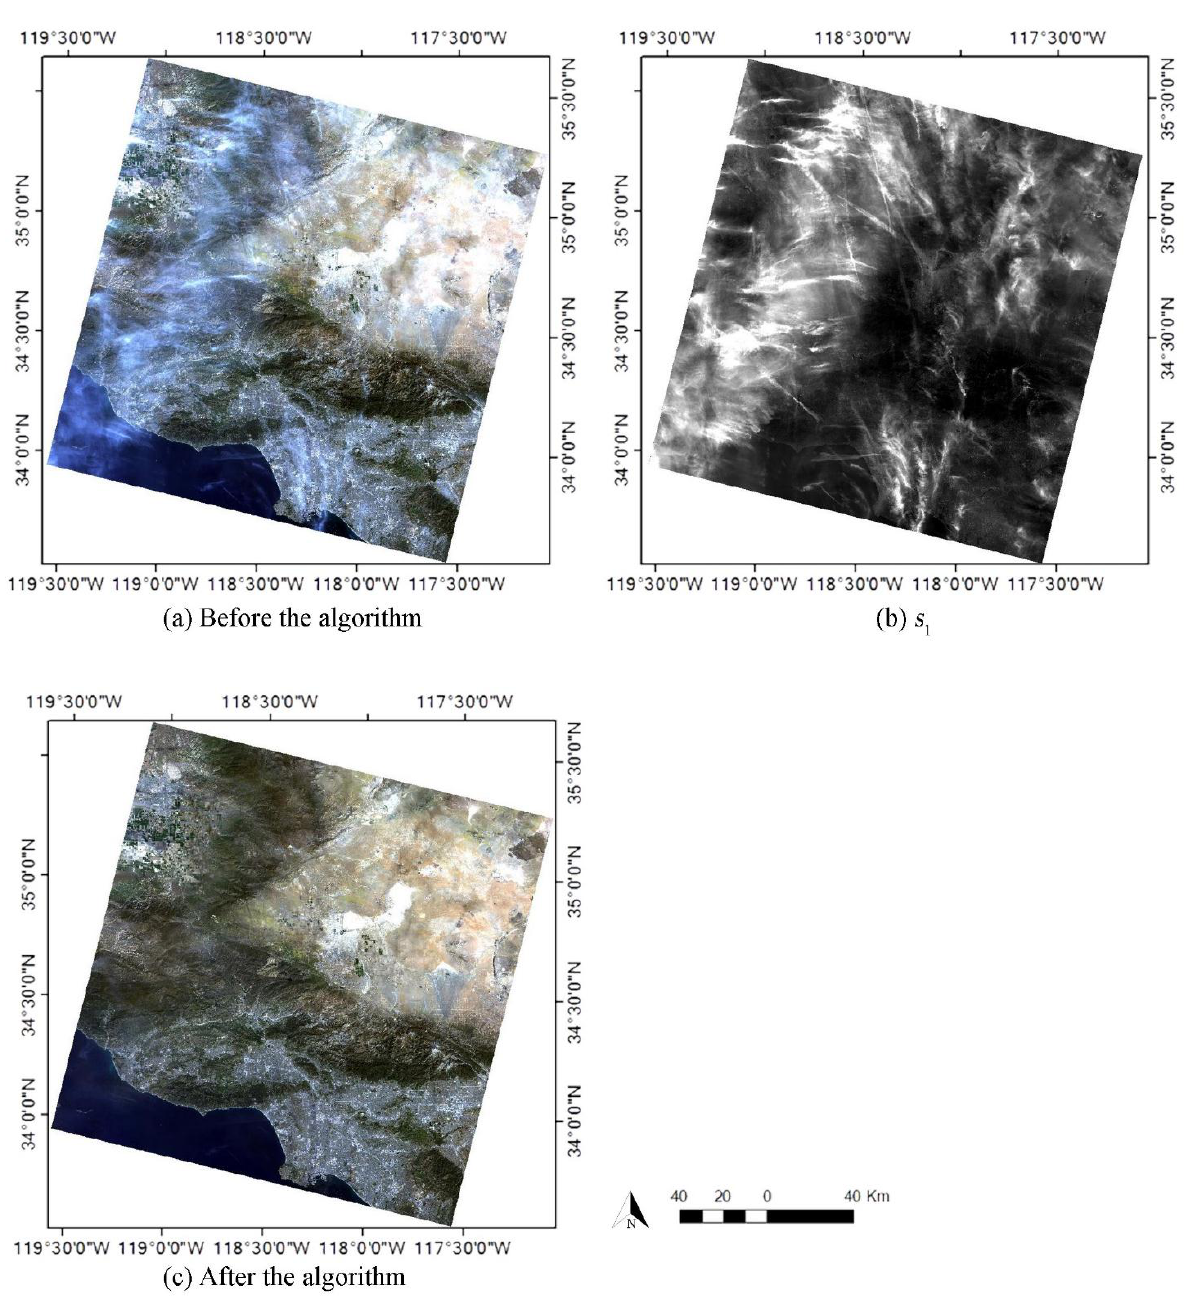
Figure 12. ( a ) The Landsat image of p41/r36 was acquired on 16 March 2015; ( b ) The cloud component, s 1 in gray scale; ( c ) The Landsat image after the algorithm. Color composites before ( a ) and after ( b ) the algorithm were with Band 4 as red, Band 3 as green, and Band 2 as